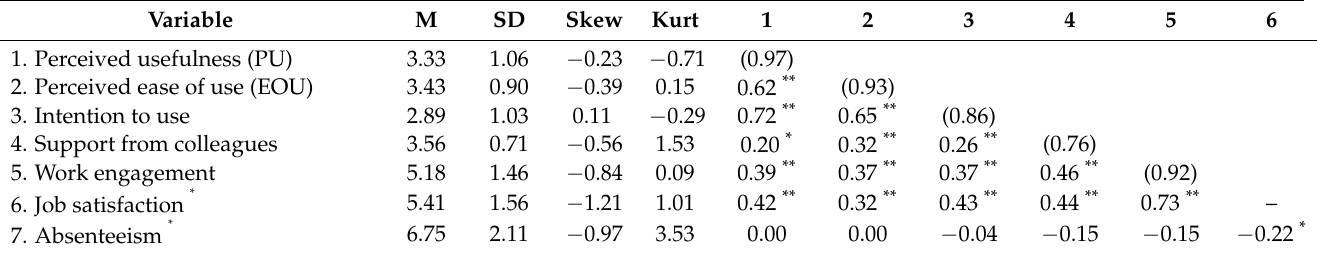
Table 1. Means, standard deviations and correlations among study variables ( N =